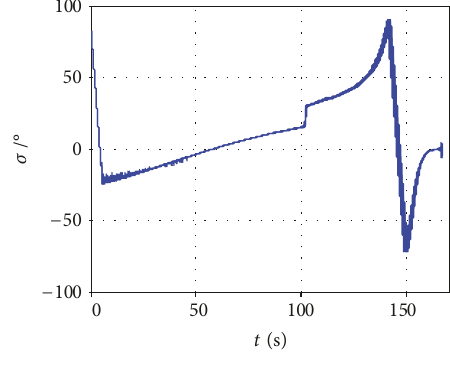
Figure 14: Bank angle results.